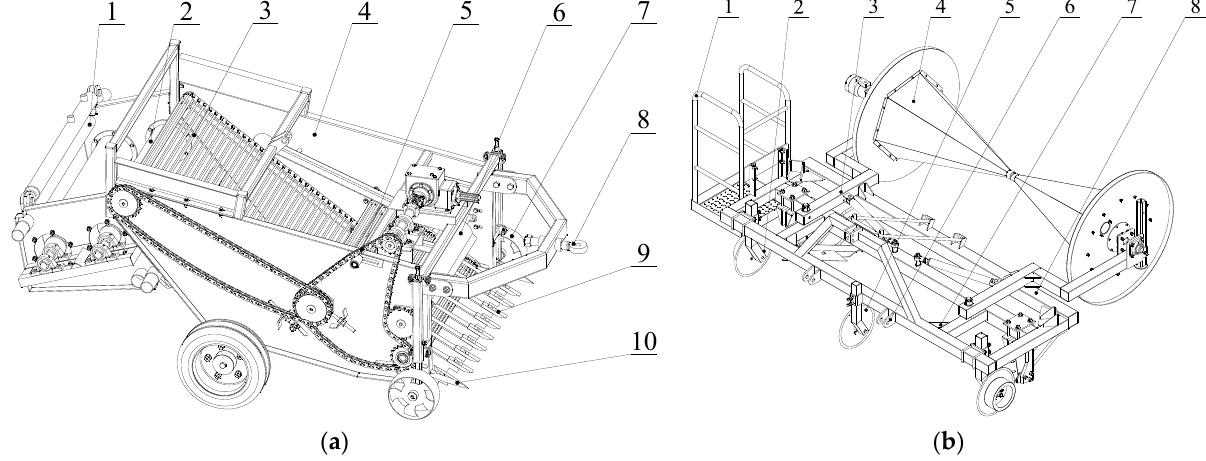
Figure 9. Schematic diagram of structure of two types of curl-up film collectors. ( a ) 11SM-1.2 curl- up film collector: 1—film-unloading mechanism, 2—film-curling mechanism, 3—film-guiding and impurity separation mechanism, 4—body frame, 5—drive system, 6—film-pulling mechanism, 7— depth wheel components, 8—traction mechanism, 9—film pick-up mechanism, 10—side-film shovel; ( b ) 1JRM-2000 curl-up film collector: 1—operation platform, 2—depth limiter, 3—film-unloading mechanism, 3—film-curling mechanism, 4—film-cutting mechanism, 5—traction mechanism, 6—film pick-up mechanism, 8—body